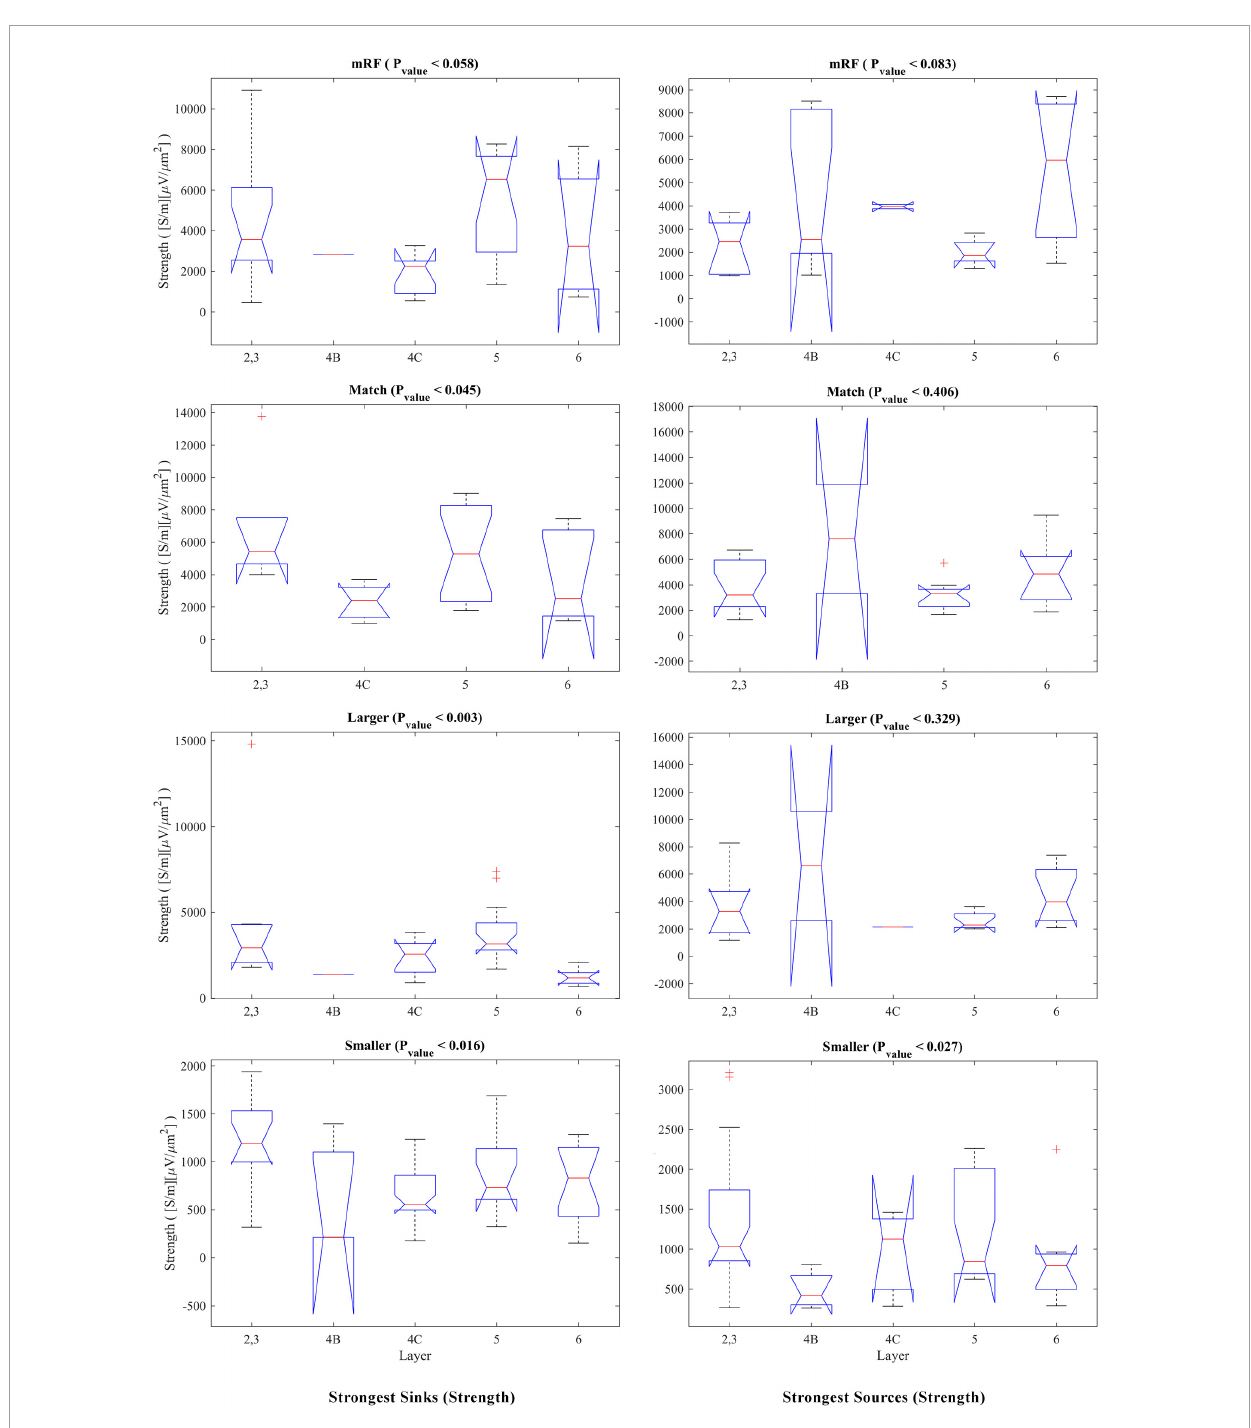
FIGURE7 Kruskal–Wallis test for the strongest sinks (left column) and sources (right column) strengths by differentiating the layers. In the upper part of each diagram, the type of stimulus and the P value related to the Kruskal–Wallis test are indicated.